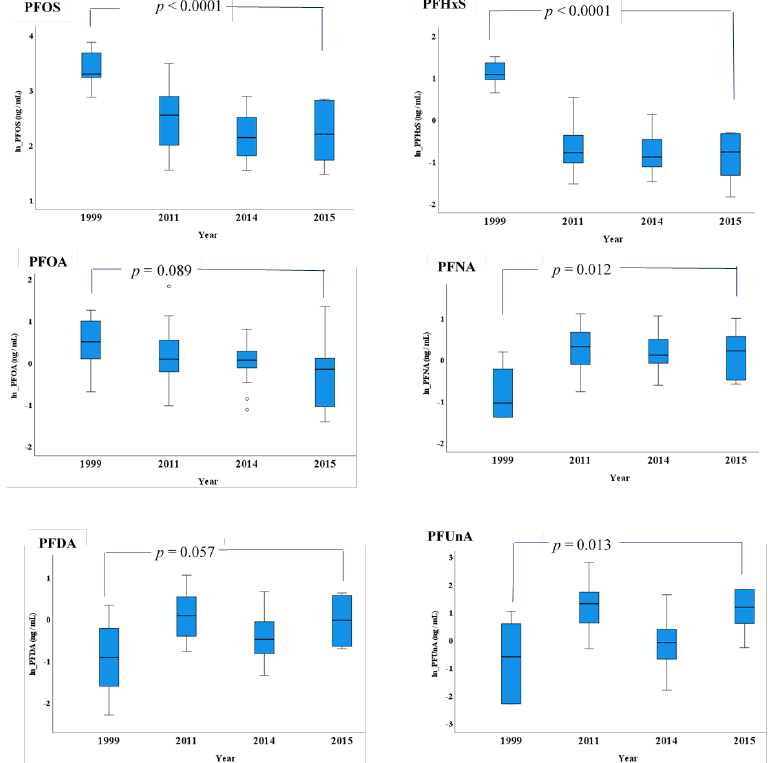
Figure 4. The levels of PFASs in Ilulissat women in 1999 ( n = 10), 2011 ( n = 33), 2014 ( n = 20) and 2015 ( n = 6). The boxes display the 25th and 75th centiles, and the line inside the boxes represents the median value. The whiskers display the lower and upper values within 1.5 times the interquartile range beyond the box. The data are raw data and in ln-transformed scale. The figure in normal scale is given as Figure S3. The p values are from analysis of covariance (ANCOVA) on ln-transformed data under the adjustment of age. PFASs: perfluoroalkylated substances. For the full name of single PFAS congeners, please refer to the abbreviation list.